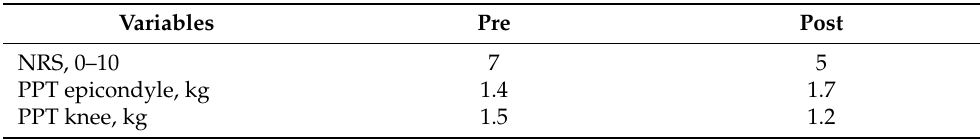
Table 3. NRS and PPT values before and after the